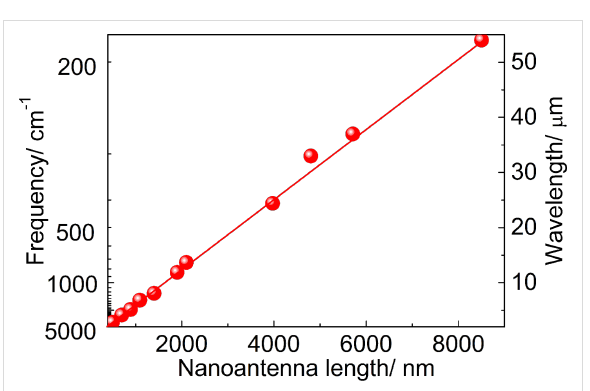
Figure 3: LSPR energy in nanoantenna arrays fabricated on bare Si surfaces as a function of the nanoantenna length.